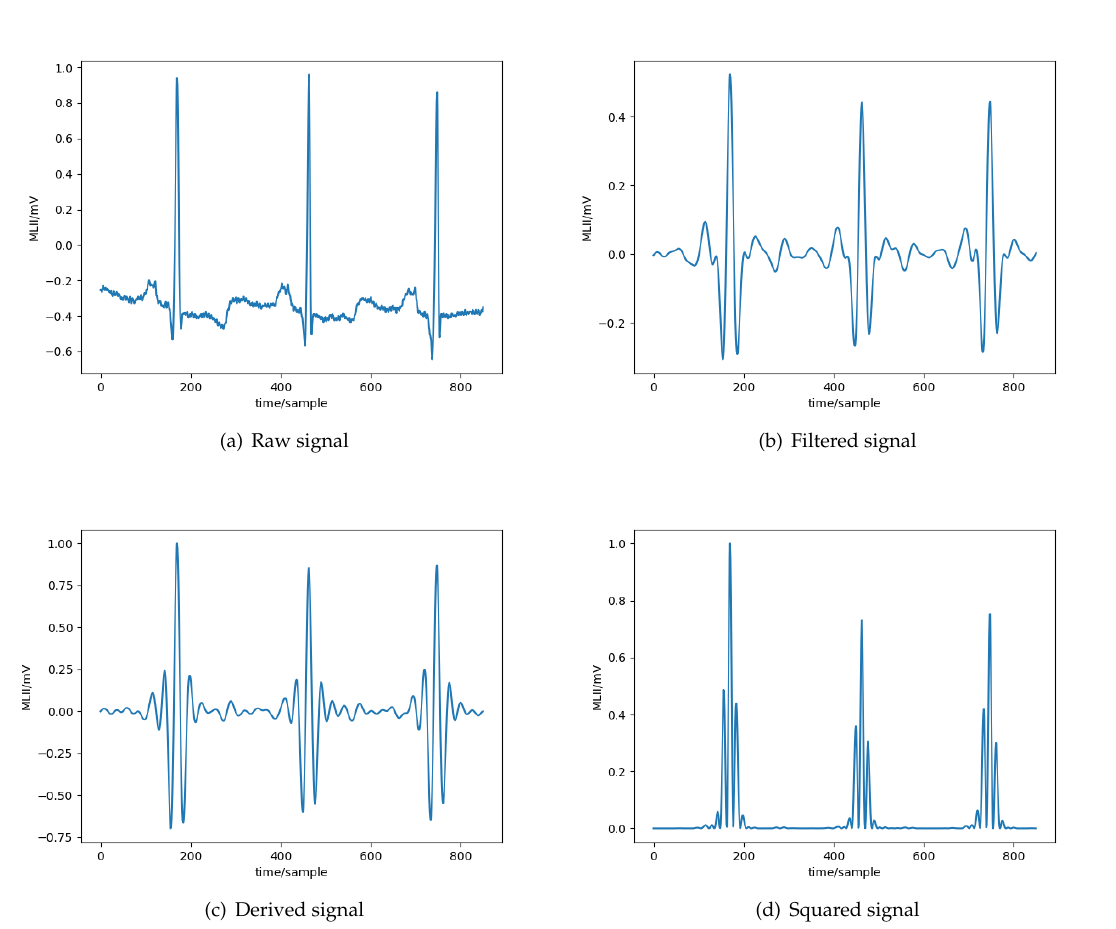
Figure 3. Different phases of the processing of the ECG